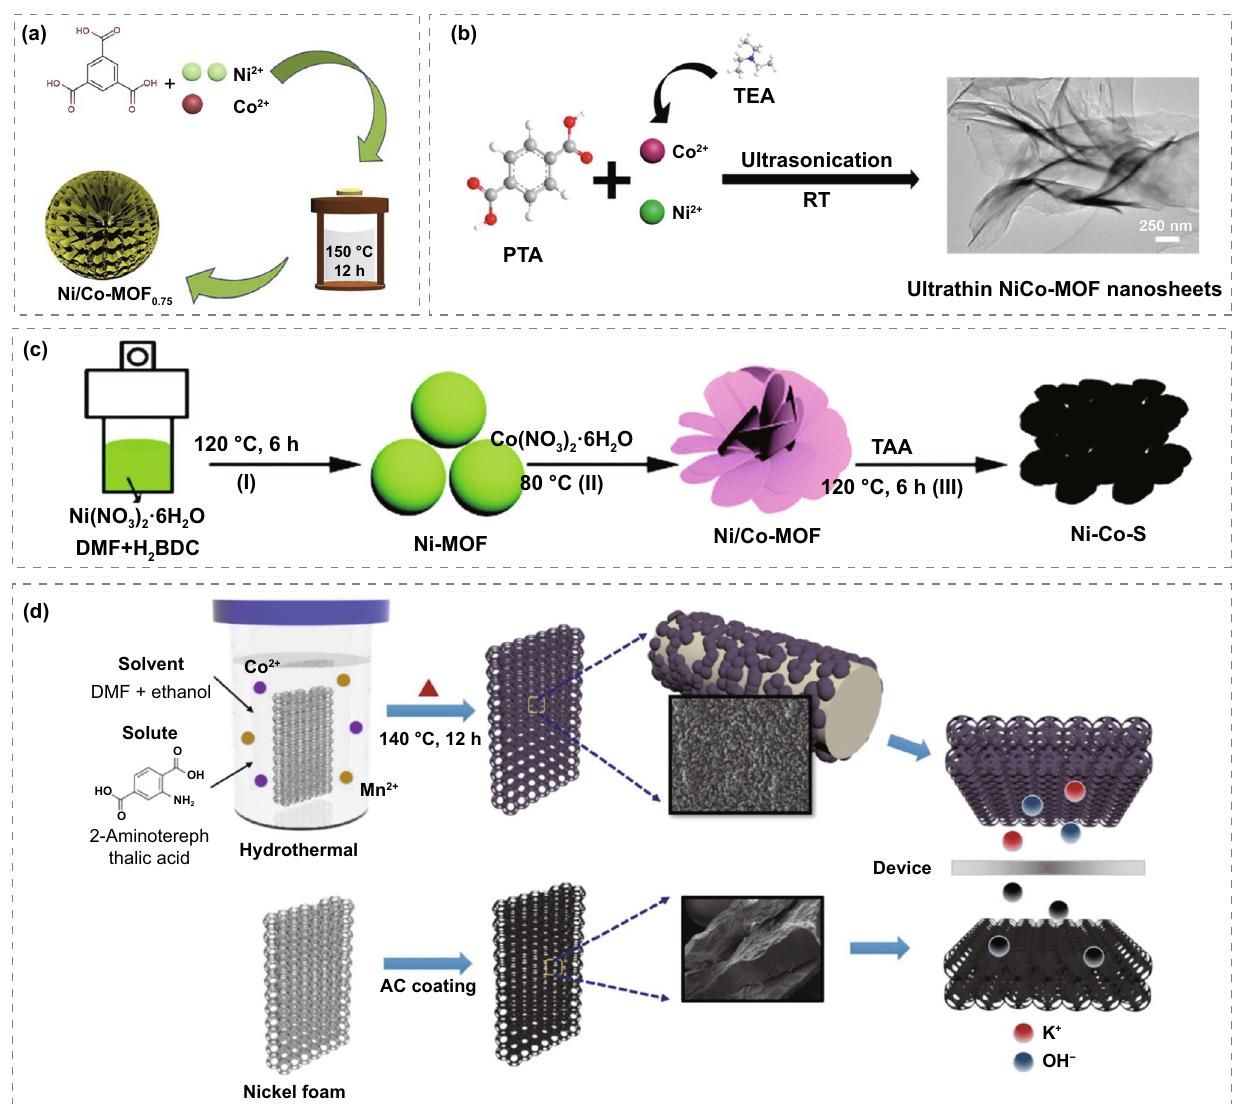
Fig. 6 a Schematic diagram of the synthesis process. Reprinted with permission from Ref. [99]. Copyright 2020 Elsevier B.V. b Preparation technology of NiCo-MOF. Reprinted with permission from Ref. [100].Copyright 2019 American Chemical Society. c Schematic diagram of Ni/ Co-MOF preparation process. Reprinted with permission from Ref. [102]. Copyright 2018 Royal Society of Chemistry. d Schematic diagram of the preparation of bimetallic Co/Mn-MOF and activated carbon. Reprinted with permission from Ref. [104]. Copyright 2019 Elsevier